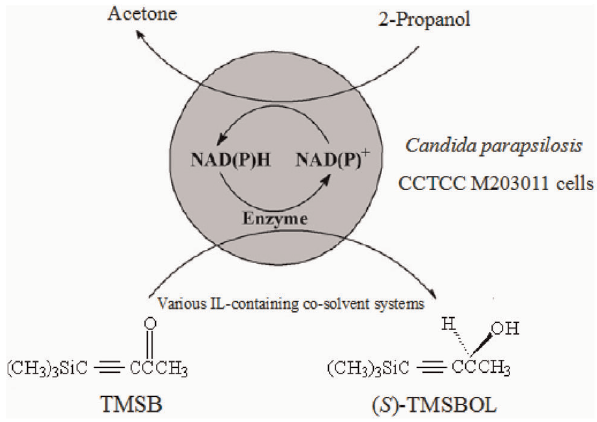
Figure 1. The bioreduction of TMSB to ( S )-TMSBOL with immobilized Candida parapsilosis CCTCC M203011 cells in various IL-containing co-solvent systems.